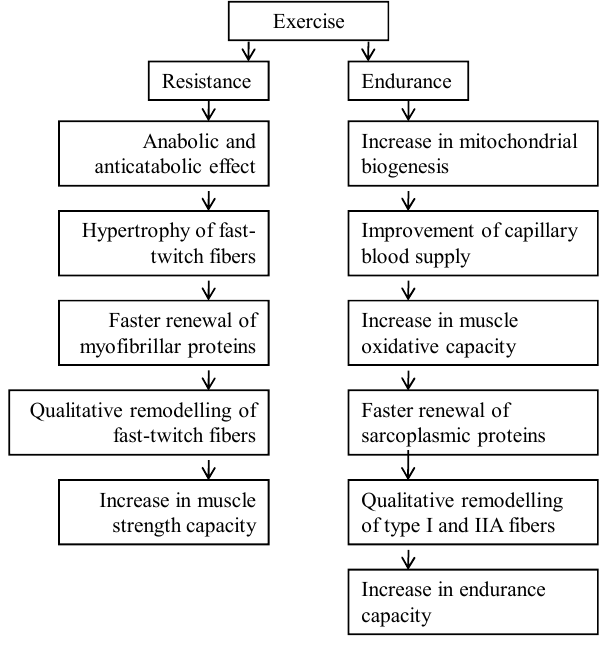
Figure 3. Effect of increased functional activity on skeletal muscle.